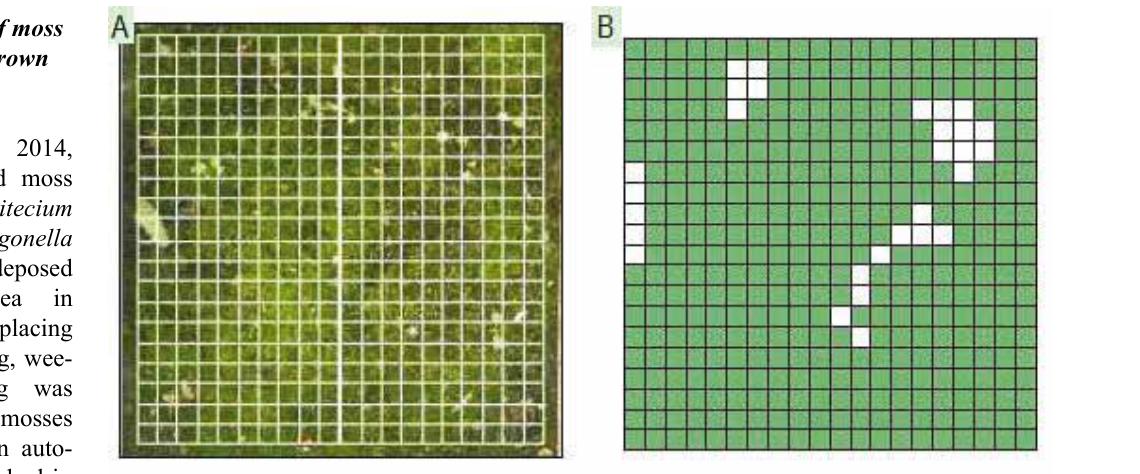
Figure 3 . As data’s evaluation, quadrats including 1 x 1 or 5 x 5 cm sized scales were designed ( A ), and covered areas were coloured for precise determining of coveration ( B ).